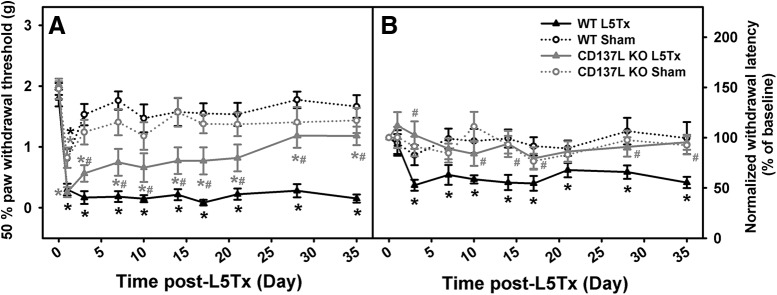

Decreased mechanical and heat hypersensitivity was observed in L5Tx CD137L KO mice. Mechanical (A) and heat (B) sensitivities in CD137L KO (gray) and WT (black) mice following a sham (open circles/dashed line) or L5Tx (triangles/solid line) surgery are shown. Data show mean ± SEM of 12 mice/group. For Hargreaves data, individual baseline responding was set to 100% within each group. Equal numbers of male and female mice were used in this experiment. Due to a lack of sex differences, results shown are collapsed across sex; *p ≤ 0.05, significantly different from corresponding baseline level on day 0; #p ≤ 0.05, significantly different from the L5Tx WT group at the same time point.